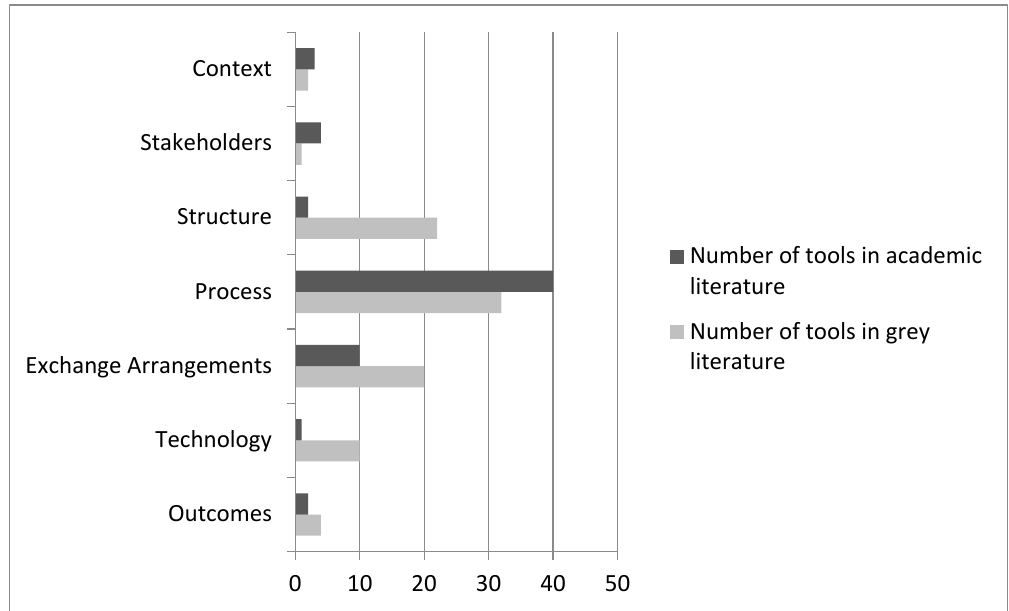
Figure 7. Number of tools found for each category in the grey and academic literature.